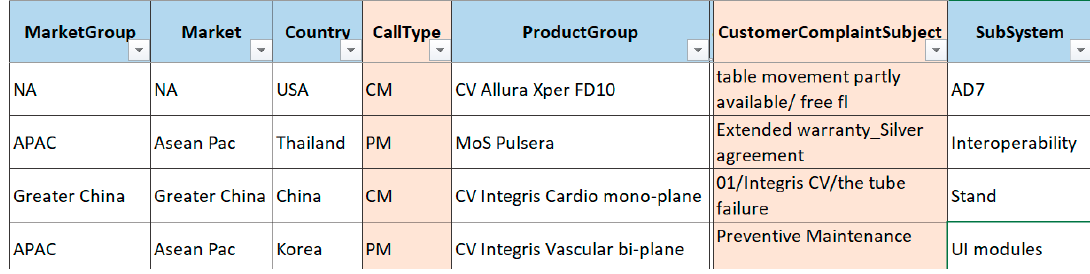
Figure 7. Snippet from sample Customer Call Log file.